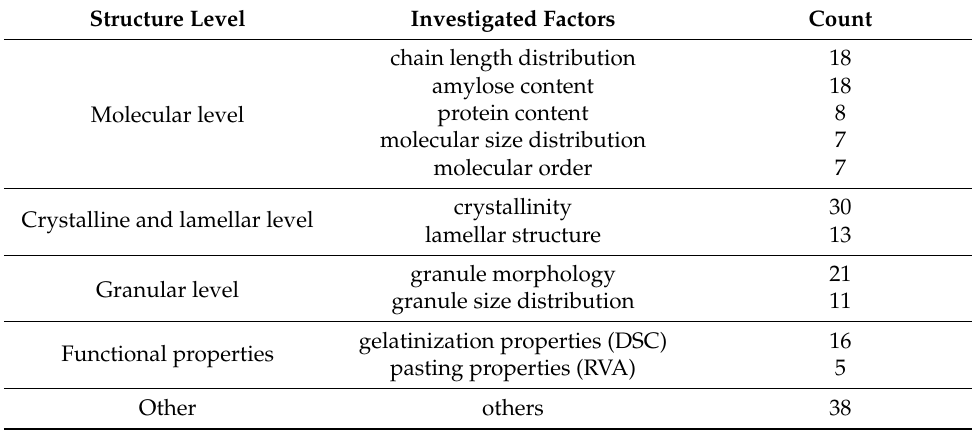
Table 3. Factors investigated by the selected